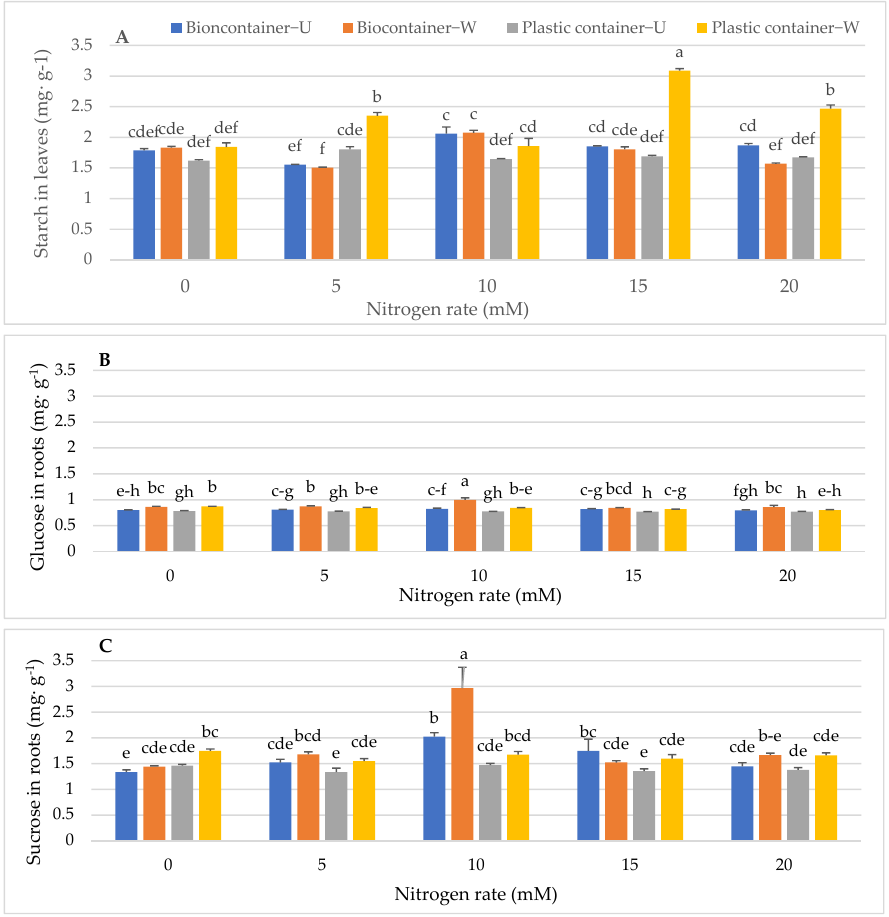
Figure 2 . Carbohydrate concentrations including starch in leaves ( A ), glucose in roots ( B ), and sucrose in roots ( C ) in Encore ® azalea ‘Chiffon’ affected by the interaction among N rate, container type, and foliar urea spray. Different lower-case letters in each chart suggest a significant differ- ence among all treatment combinations indicated by Tukey’s HSD test at p ≤ 0.05. Table 6. Distribution of carbohydrates in Encore ® azalea ‘Chiffon’ among leaves, stems and roots.